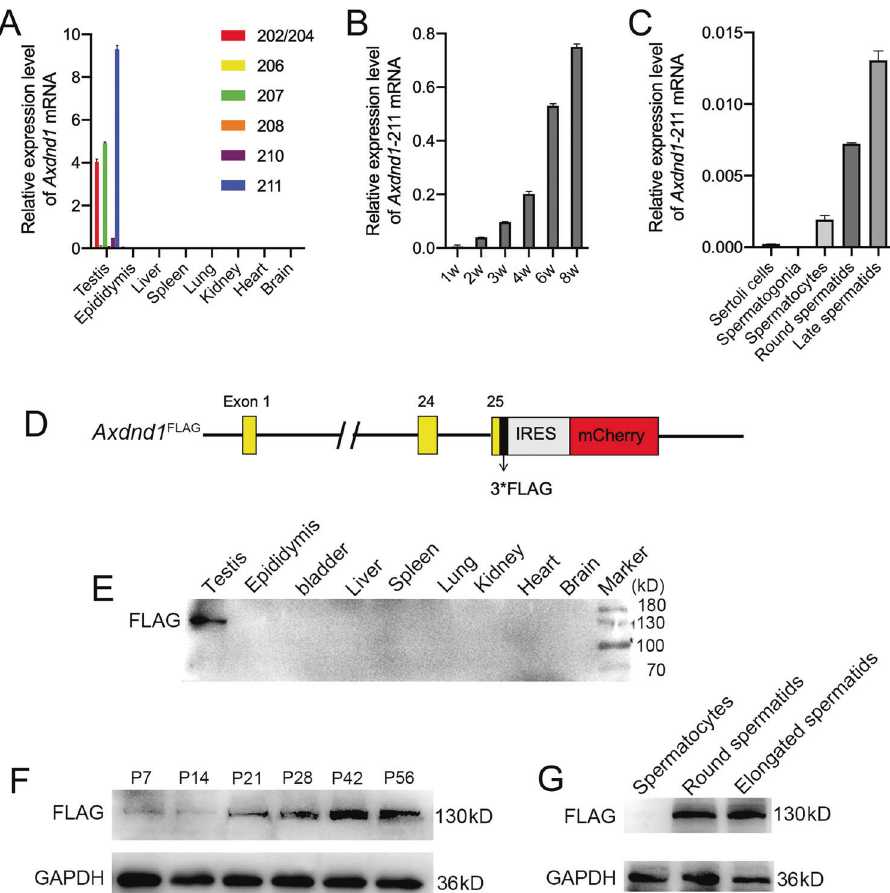
Fig. 2 The expression pattern of AXDND1 in mouse testis. A The expression pro fi le of different isoforms of Axdnd1 transcripts in various mouse tissues is analyzed by RT-qPCR. B Expression of the most enriched full-length Axdnd1 transcript ( Axdnd1 -211) in the testes of mice aged 1, 2, 3, 4, 6, and 8 weeks. C Relative mRNA levels of Axdnd1 -211 in isolated mouse testicular germ cells. D The schematic of the generation of a mouse model expressing FLAG-tagged AXDND1 is shown. E – G Western blot analyses of AXDND1 expression in multiple tissues ( b ), developmental testes ( F ), and isolated germ cells ( G ) from Axdnd1 FLAG/FLAG male mice are shown. GAPDH served as a loading